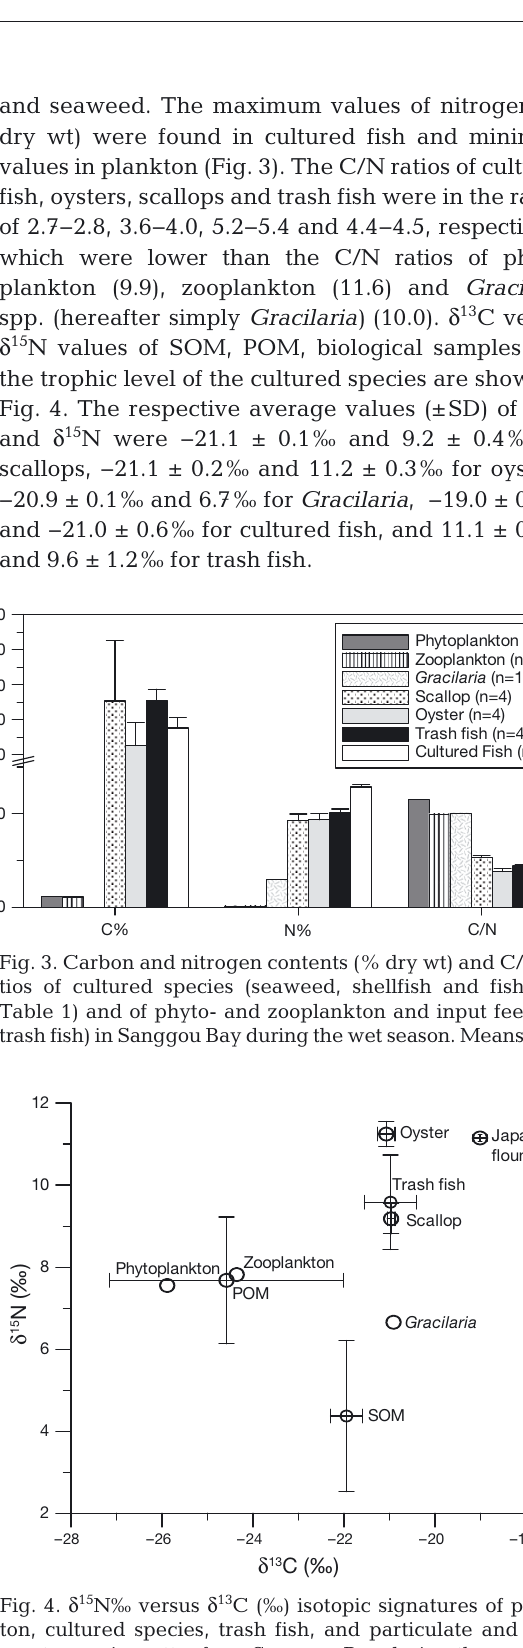
Fig. 4. δ 15 N‰ versus δ 13 C (‰) isotopic signatures of plank- ton, cultured species, trash fish, and particulate and sedi- ment organic matter from Sanggou Bay during the wet sea- son. Means given ±SD, if n >